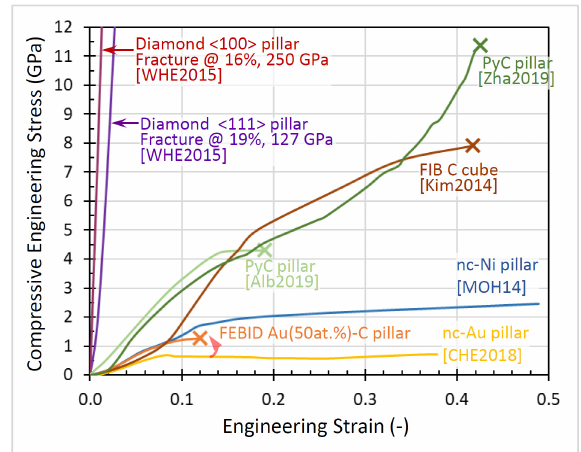
Figure 20. Compilation of pillar nanocompression experiments of varying materials: single crystal diamond [120], pyrolytic graphite (PyC) [118,119], nanocrystalline nickel (nc-NI) [122], nanocrystalline gold (nc-Au) [121], FEBID Au-C pillar (this work), and an FIB carbon cube of amorphous hydrogenated carbon [41]. The crosses signify the appearance of cracks or catastrophic fracture. Note the ductility of all pillars in contrast to the sti ff and brittle diamond pillars.